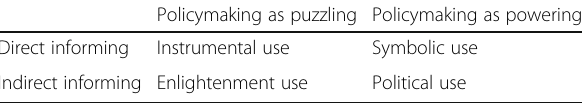
Table 1 Typology of knowledge use based on